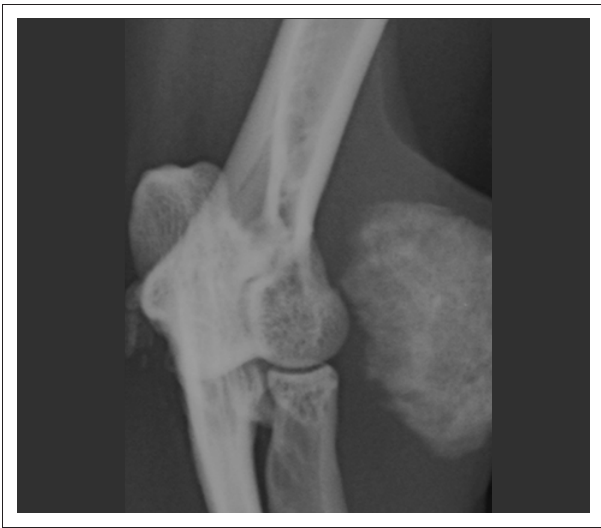
FIGURE 3: Craniolateral-caudomedial oblique view of the left elbow of a cat positive for feline leukaemia virus, clearly showing the mass as unattached to the bone. Calcification of the flexor tendon origin is also present and considered an incidental finding.